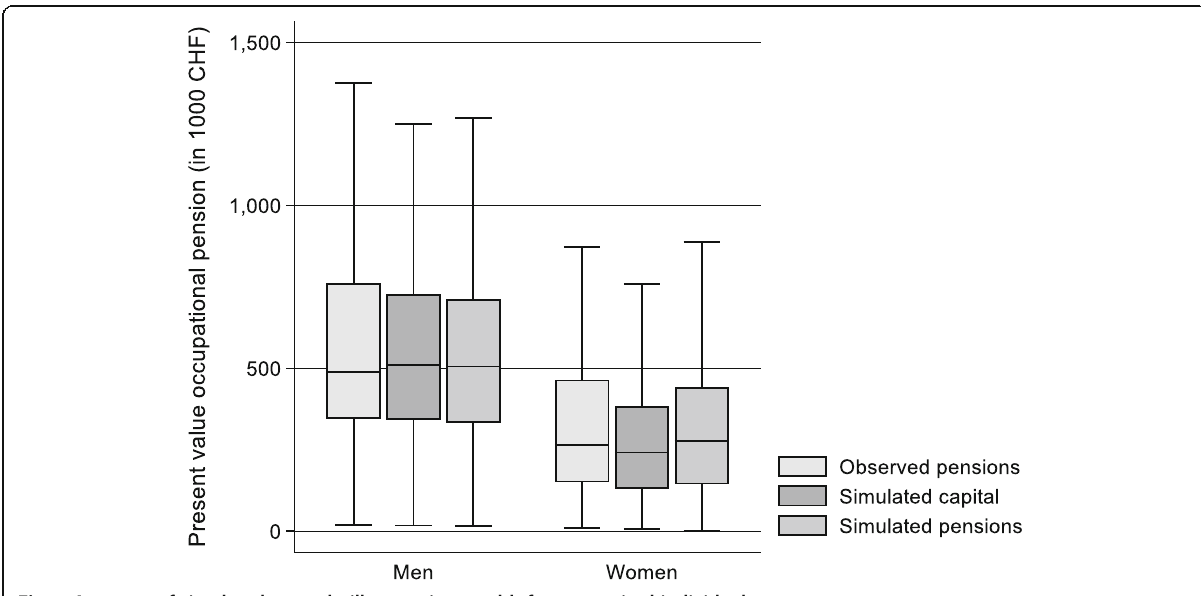
Fig. 4 Accuracy of simulated second pillar pension wealth for non-retired individuals